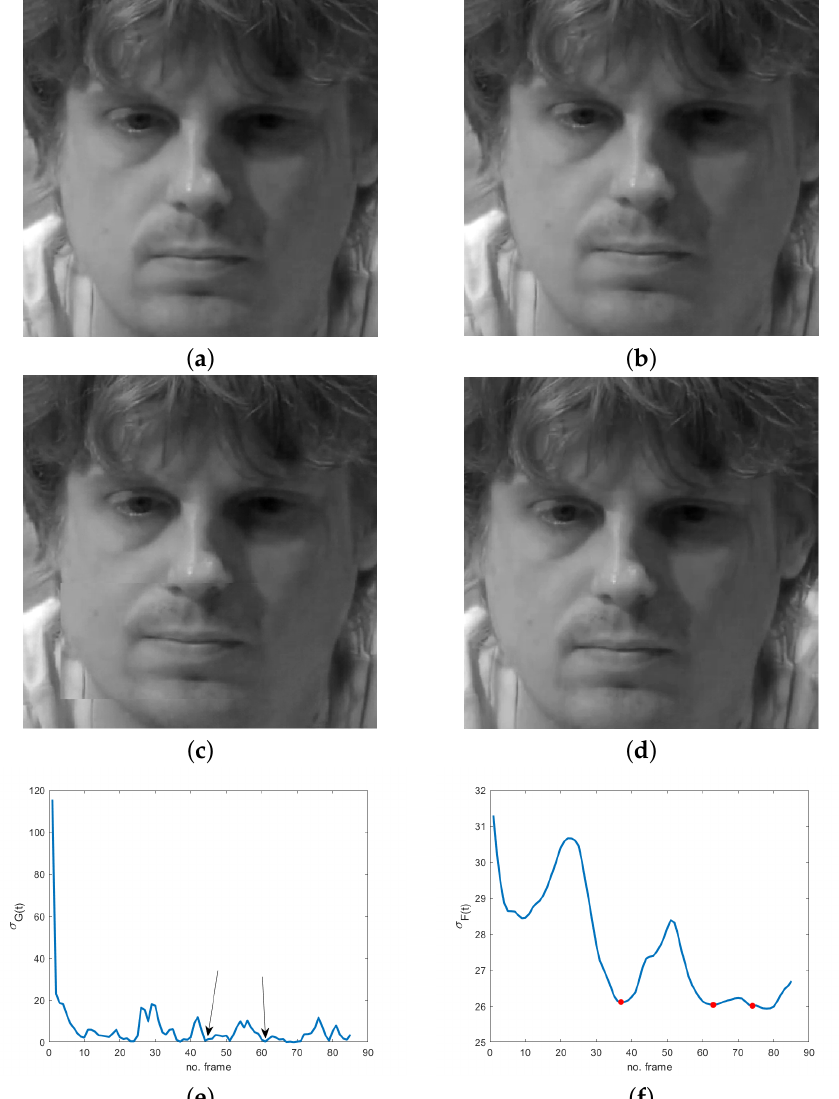
Figure 3. Four frames of the sequence cut 1.1 from the MEVIEW dataset [38]: ( a ) frozen frame before ME (contempt); ( b ) ME onset; ( c ) ME apex; ( d ) frozen frame after ME; ( e ) temporal global energy measured as the standard deviation of the spatio-temporal filtered sequence using the filter in Equation (1)—the arrows indicate frozen frames; ( f ) standard deviation of the spatio-temporal filtered sequence using the filter l ( x , y , t ) in Equation (2) restricted to the group of frames containing the ME—markers correspond to local